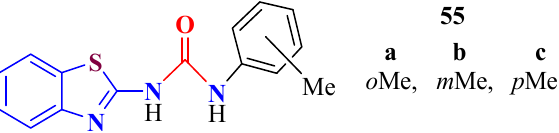
Figure 8. The 5-substituted alcohol-containing ethyl-UBTs 52a – s , 53a – g , and 54a – k . In a typical reaction, ortho -, meta -, or para -tolyl-isocyanates were treated with 2ABT in the presence of 1,4-dioxane at room temperature to synthetize three tolyl-UBTs 55a – c to evaluate their inhibitory effects on α -chymotrypsin enzyme, Figure 9 [147]. It was found the para -substituted N -(1,3-benzothiazol-2-yl)- N ′ -(4-methylphenyl) urea 55c derivative substantially inhibited α -chymotrypsin activity (IC 50 = 20.6 ± 0.06 μ M). Due to the presences of the bulky 1,3-benzothiazol-2-yl group at one nitrogen of the urea bridge, the activity is enhanced by the reduction of the steric hindrance in the order ortho > metha > para .